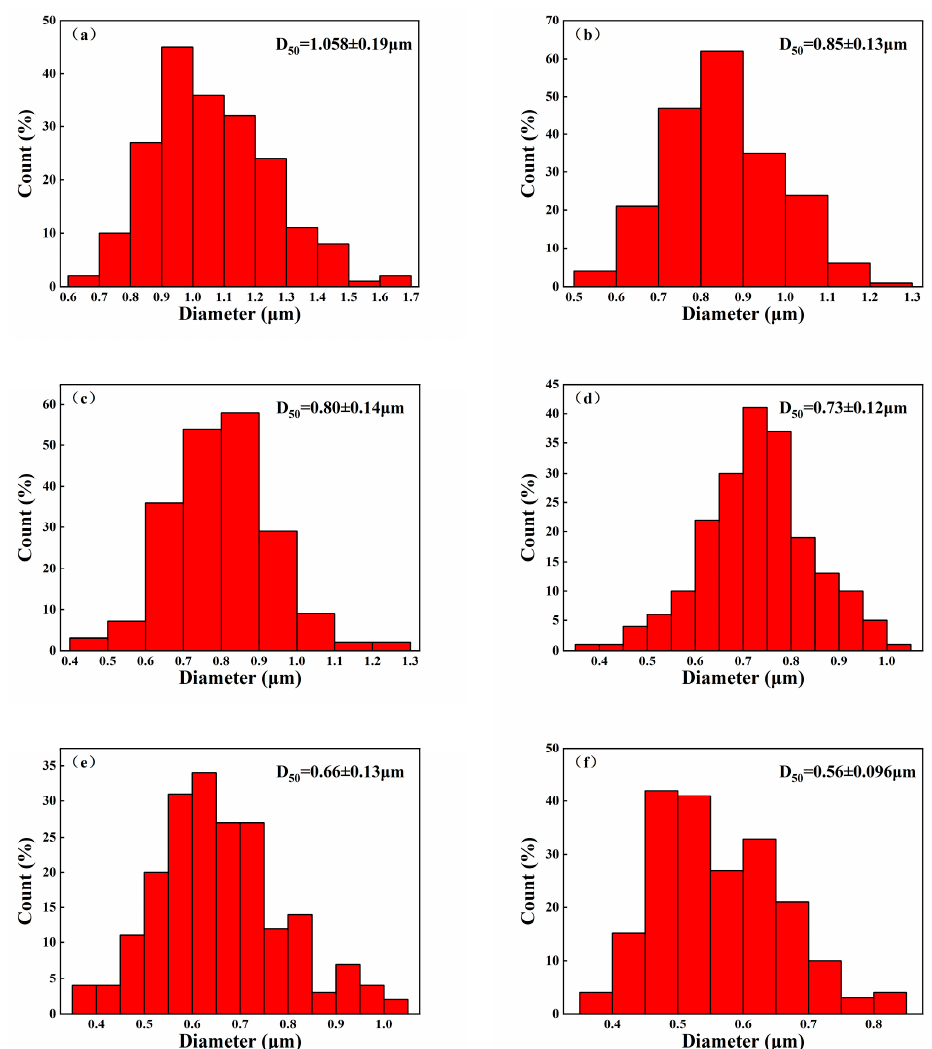
Figure 9. Particle size distribution of the sintered samples with different coupling media at 1575 °C for 2 h. ( a ) sample A, ( b ) sample B, ( c ) sample C, ( d ) sample D, ( e ) sample E, and ( f ) sample F. (Abnormally large grains were not involved in the statistics).